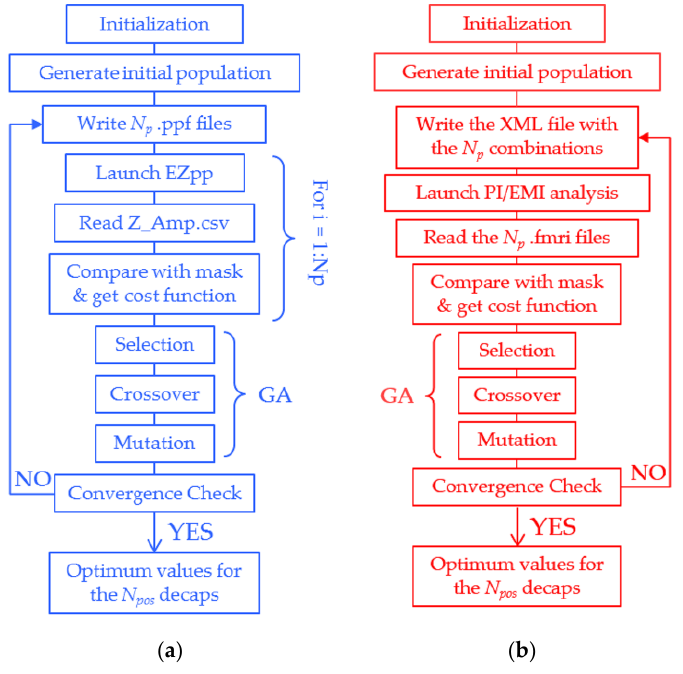
Figure 6. Optimization flow for ( a ) EZpp and ( b ) DF PI.